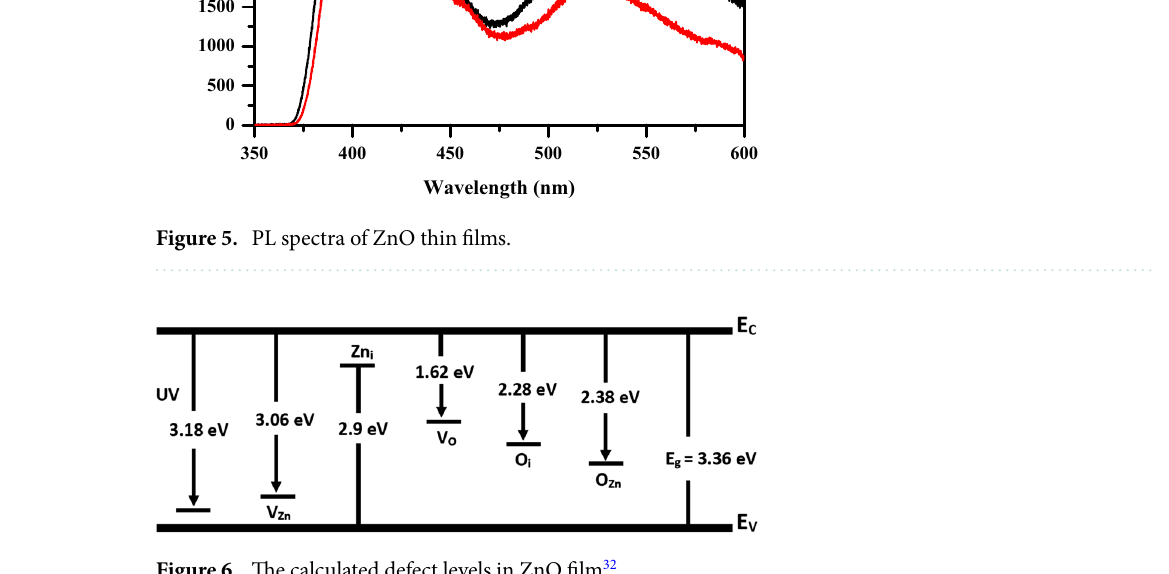
Figure 6. The calculated defect levels in ZnO film 32 .